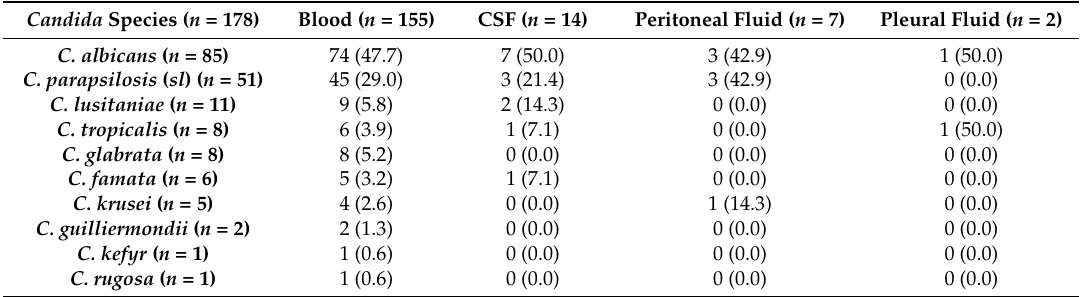
Table 1. Distribution of Candida species by infection site during the study period